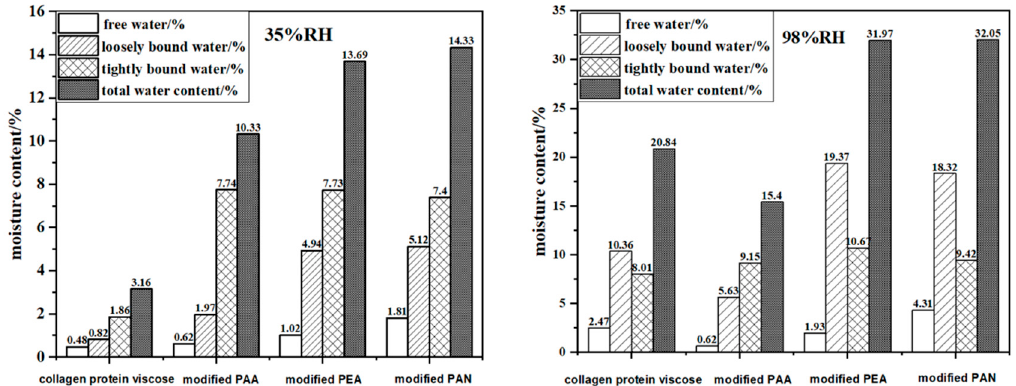
Figure 8. Moisture contents of different water formations on samples at 20 °C for 35%RH and 98%RH determined by TGA–DSC analysis.